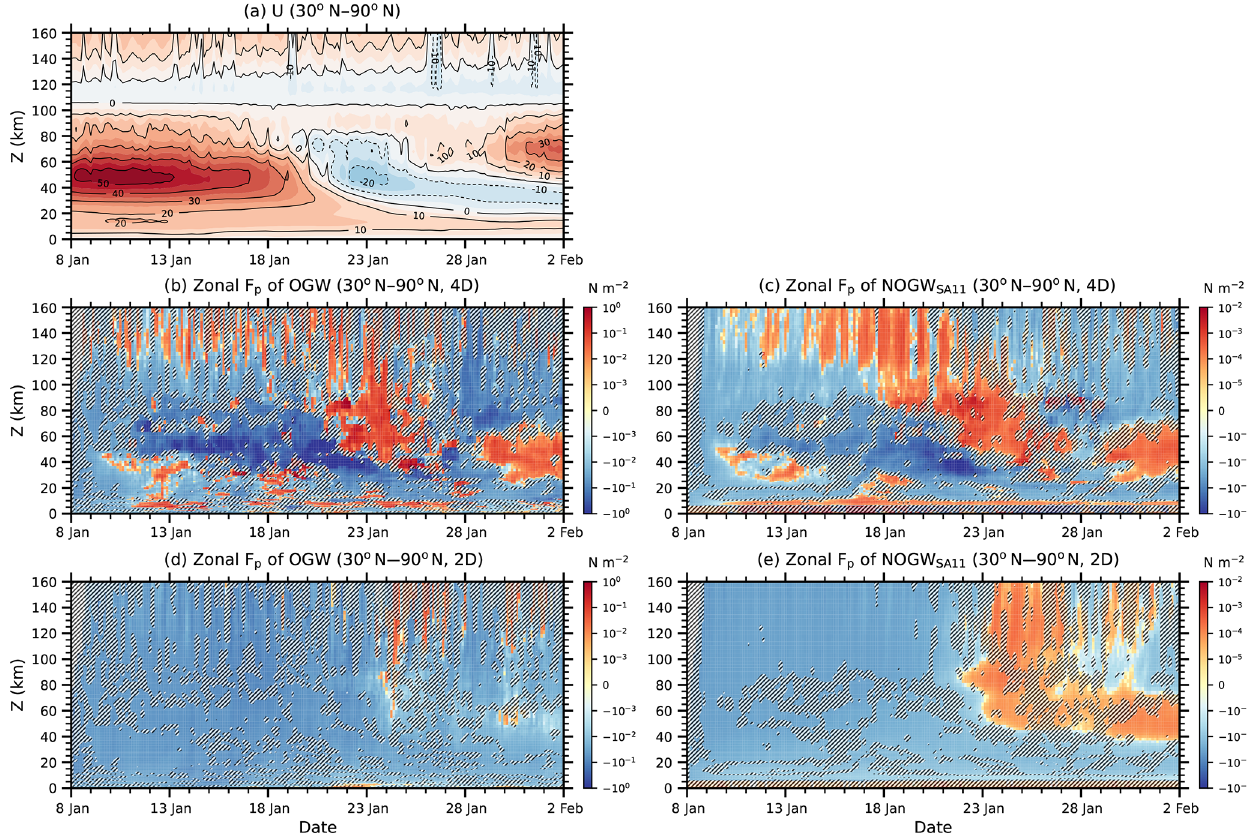
Figure 12. Time–height cross sections of (a) zonal wind ( U ), and (b–e) ensemble means of zonal pseudomomentum fluxes ( F p ) averaged over 30–90 ◦ N for OGW and NOGW SA11 in the (top row) 4D and (bottom row) 2D experiments. OGW F p is multiplied by the efficiency factor (0.125). Contour interval for zonal winds is 10ms − 1 , and negative values are plotted in broken lines. Hatched areas over the zonal F p indicates regions where the paired and two-tailed t test for the 4D and 2D experiments give p values larger than 0.05 (i.e., no statistical significance at the level of